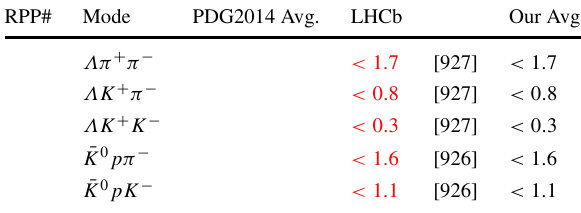
Table 231 Branching fractions of charmless Ξ 0 × 10 − 6 . Upper limits are at 90% CL. Where values are shown in red (blue), this indicates that they are new published (preliminary) results since PDG2014